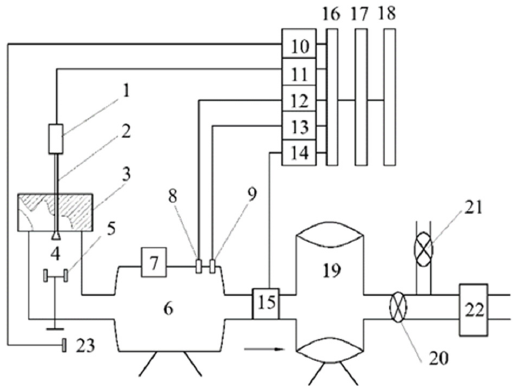
Figure 4. Diagrammatic sketch of the intelligent test bench of the swirl chamber diesel engine air- way. (1) valve lift sensor, (2) valve, (3) cylinder cover, (4) simulation cylinder, (5) blade, (6) stabiliz- ing bucket, (7) eddy momentum instrument erection joint, (8) pressure sensor, (9) temperature sen- (14) flow display, (15) flow sensor, (16) A/D junction box, (17) computer, (18) printer, (19) stabilizing